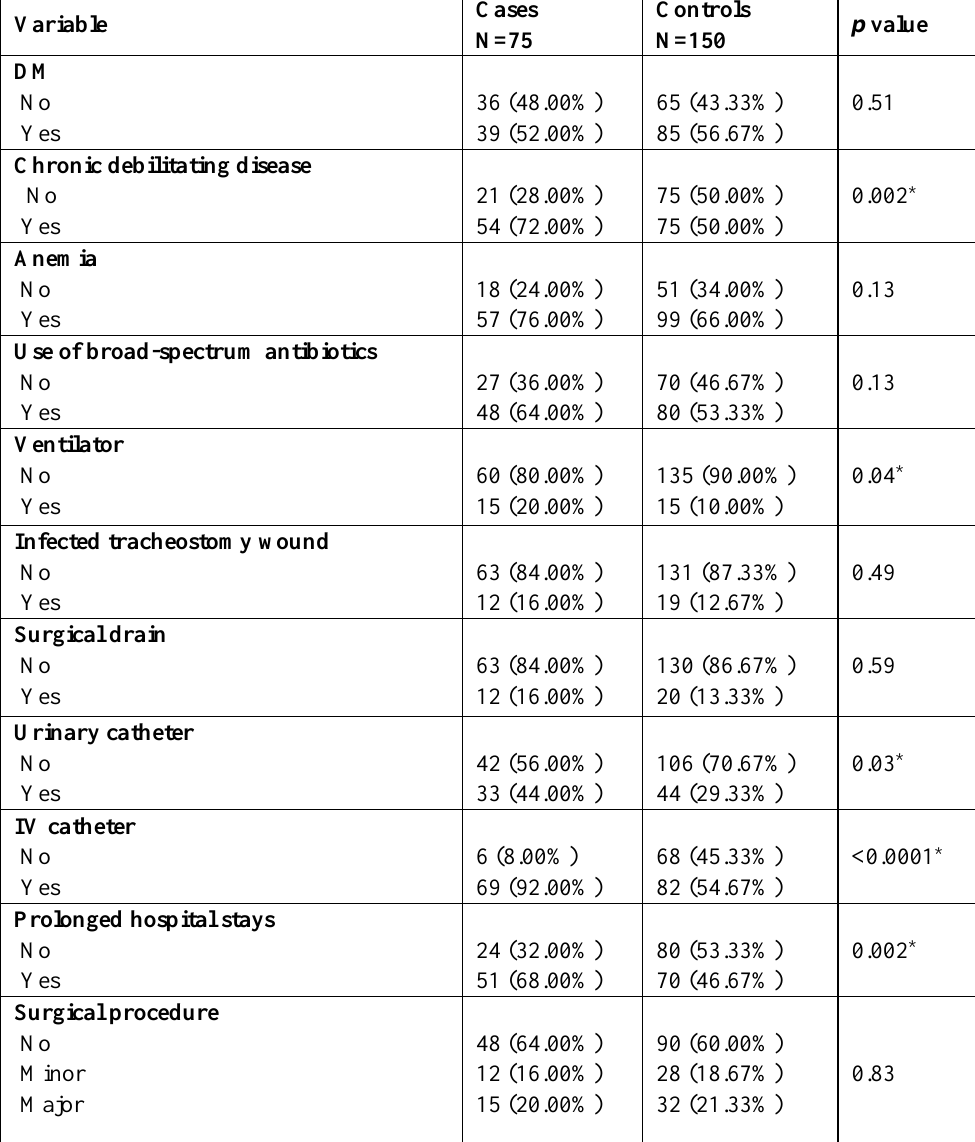
Table 3. Risk factors associated with HAIs and relation to P. aeruginosa -